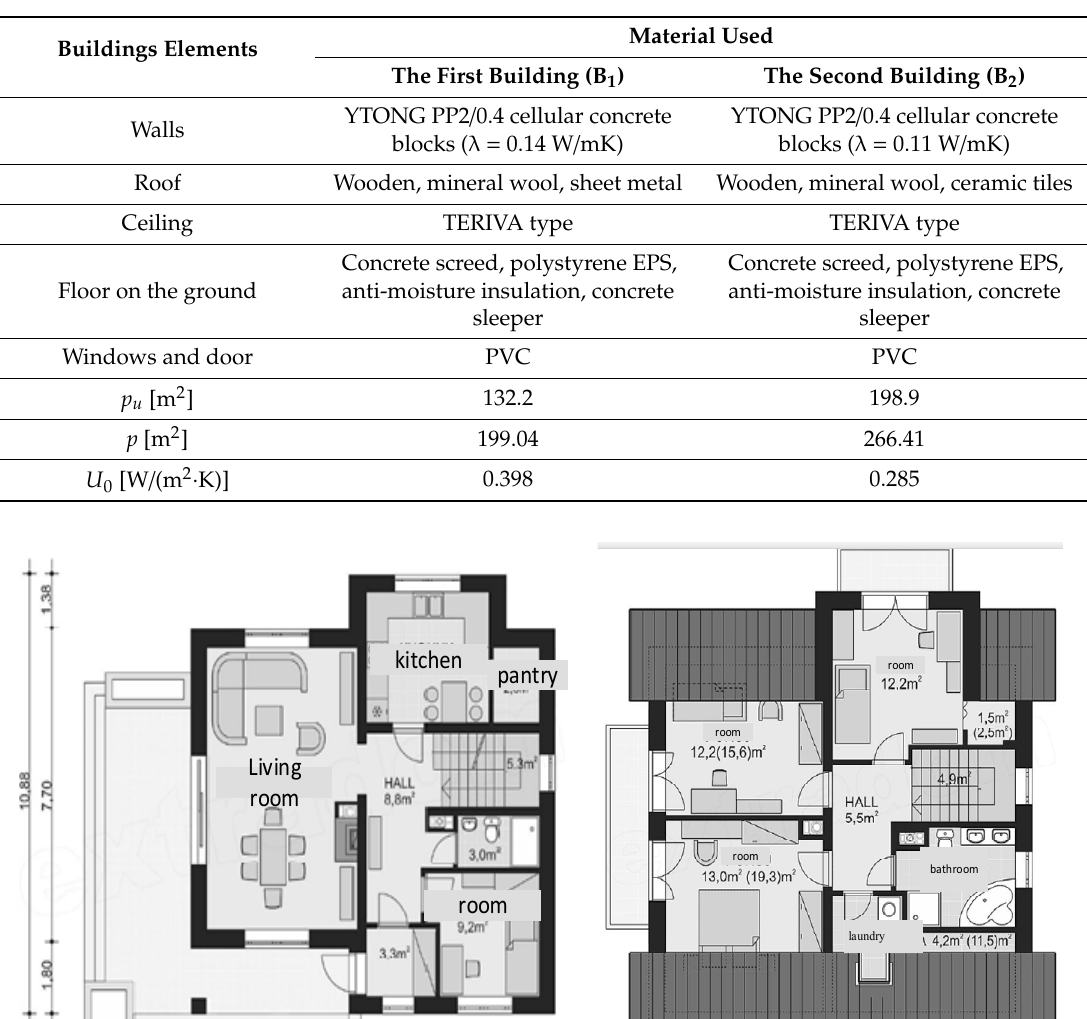
Table 2. Selected information on buildings.